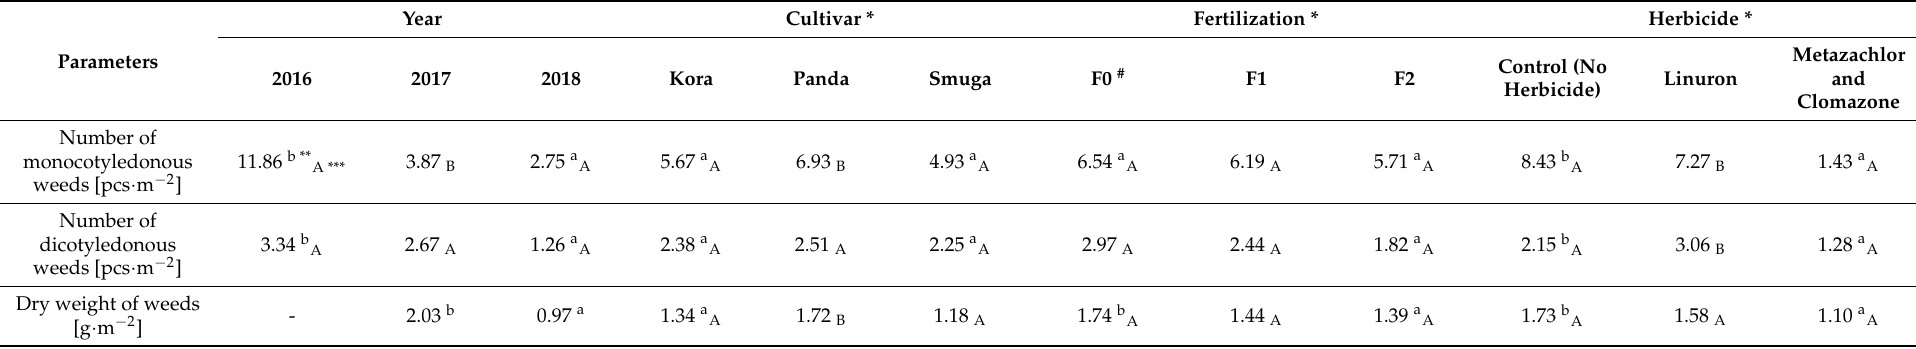
Table 7. The abundance and dry weight of the segetal